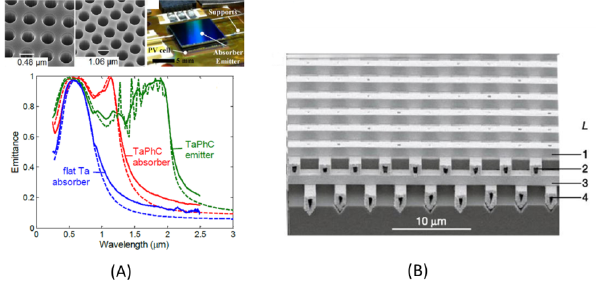
Fig. 6. PhC selective solar absorbers. (A) Two-dimensional PhC se- lective absorber and selective emitter and their measured emit- tance spectrum [6]. (B) Scanning electron microscope picture of the 3D PhC fabricated by Fleming et al. Adapted by permission from Macmillan Pulishers Ltd: Nature [61], ©